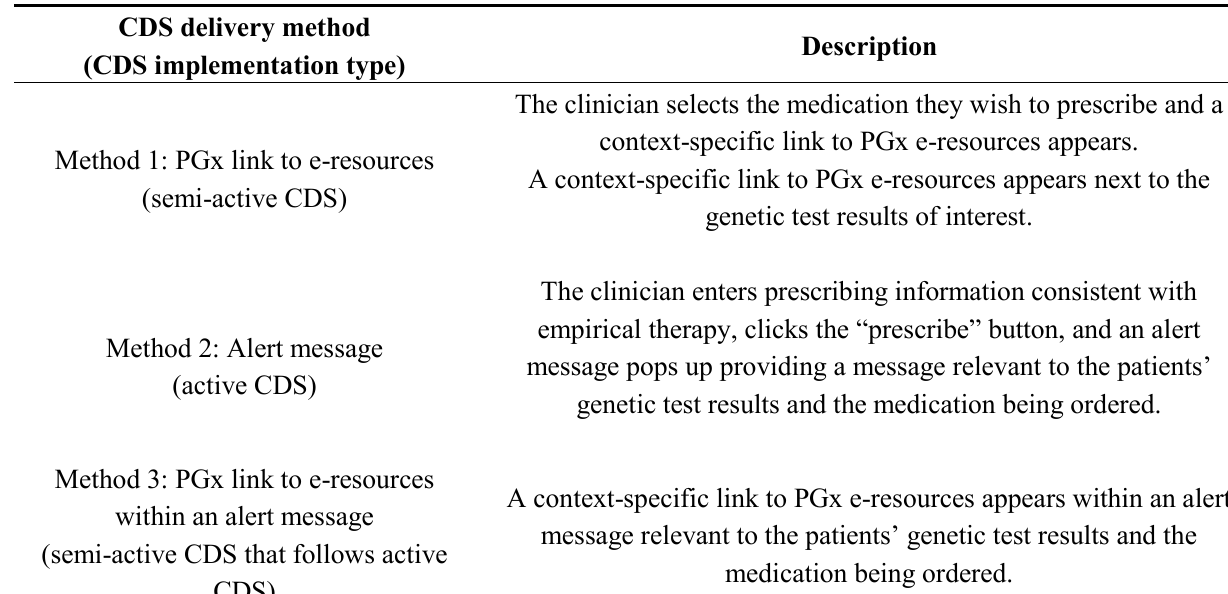
Table 1. Clinical decision support methods to deliver PGx